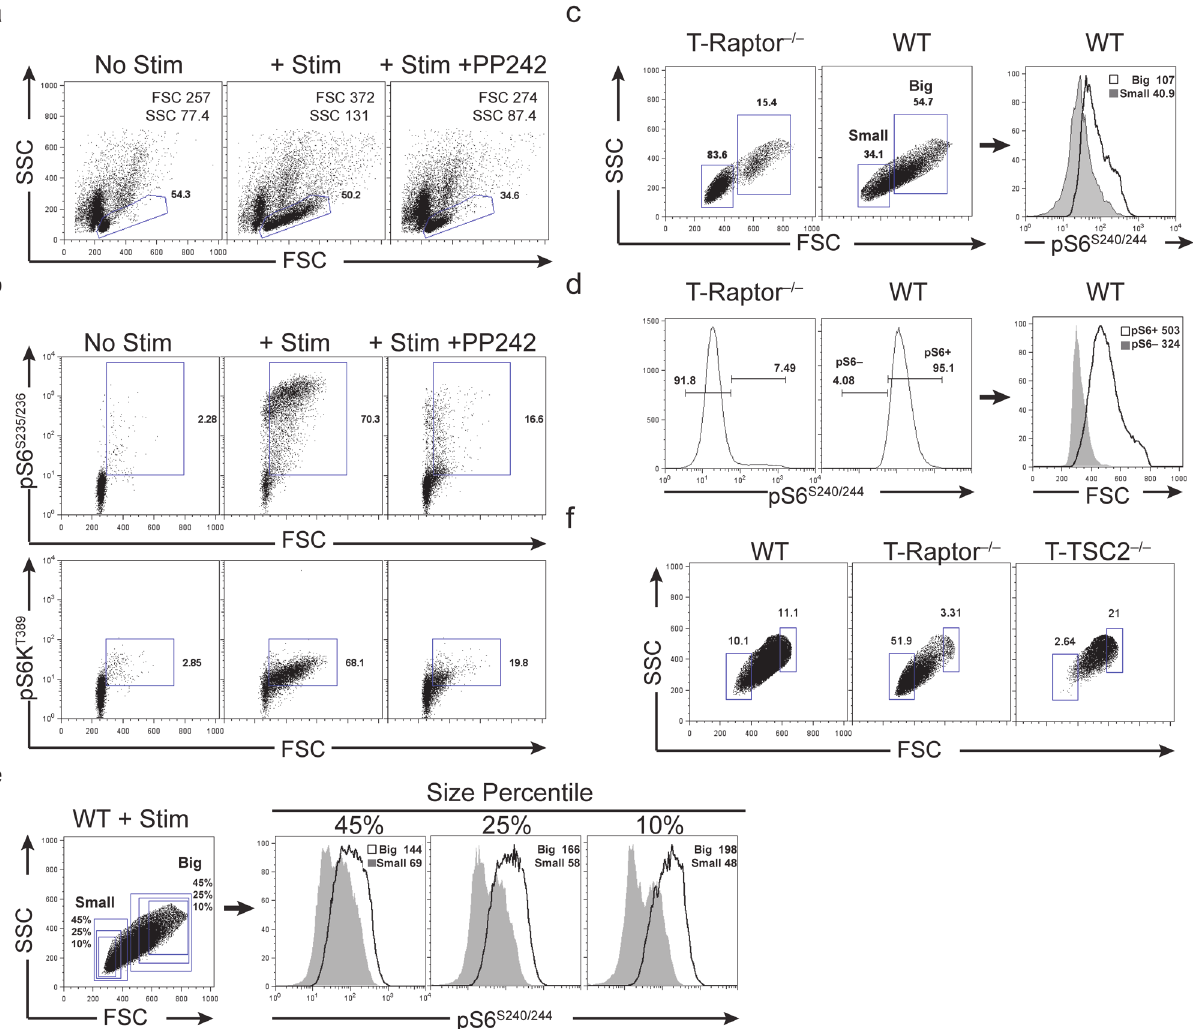
Fig 1. CD4+ T cells coordinately increase in size and mTORC1 activity following TCR stimulation. a-b) 5c.c7 Rag – / — CD4+ T cells were cultured for 24hrs in media, or media + Pigeon Cytochrome C (PCC) peptide +/- 500nM PP242, a mTOR kinase inhibitor. a) Peptide stimulated cells exhibit a significant increase in cell size relative to unstimulated controls. Stimulation-induced cell growth can be inhibited by treatment with PP242. Forward (FSC) and Side scatter (SSC) MFI are shown in top right corner of each panel. b) Peptide stimulated CD4+ T cells upregulate mTORC1 activity following TCR stimulation, as indicated by phosphorylation of downstream targets S6 and S6K. This increase in mTOR activity is diminished upon PP242 addition. c-d) WT and T-Raptor – / — OT-II+ splenocytes were stimulated with OVA 323 – 339 for 24hrs. c) Gates were set on stimulated CD4+ T cells based upon predominant size of stimulated T-Raptor – / — cells and mTORC1 activity was measured from the smallest (Small) and largest (Big) populations of WT stimulated cells. pS6 MFI shown in upper right corner of histogram FACs plot . d) Gates were set based upon phosphorylated S6 (pS6) expression detected in T-Raptor – / — cells and size (FSC) was assessed based from pS6 — and pS6+ populations of WT stimulated cells. FSC MFI shown in upper right corner of histogram FACs plot. e) 5c.c7 Rag – / — CD4+ T cells were stimulated with PCC for 24hrs and mTORC1 activity (as indicated by pS6 expression) was measured from the 45%, 20%, and 10% smallest (Small) and largest (Big) populations of cells. f) WT, T-Raptor – / — and T-TSC2 – / — OT-II+ splenocytes were stimulated with OVA 323 – 339 for 24hrs. Plots show percentage of smallest and largest cells in each genotype based on the 10% gate generated from WT stimulated cells. The data are representative of at least 3 independent